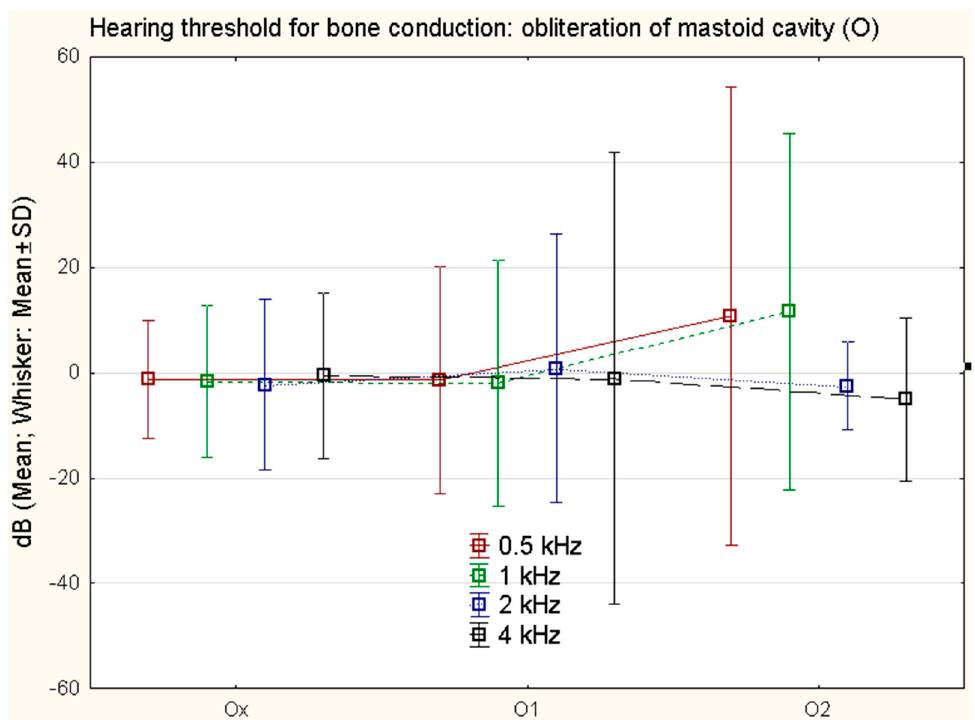
Figure 6. The difference in bone conduction prior to surgery and 1 year after surgery in different types of mastoid cavity obliteration. Ox no reconstruction, O1 partial obliteration, O2 total obliteration; at 0.5 kHz ( p = 0.007) and at 1 kHz ( p = 0.047).